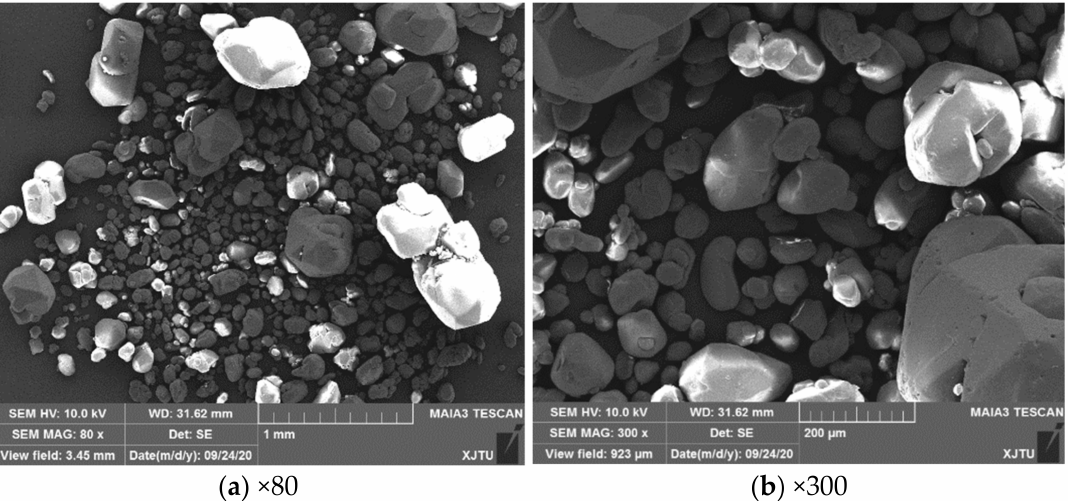
Figure 1. SEM images of the RDX sample under different magnifications. ( a ) The 80 times magnifica- tion and ( b ) 300 times